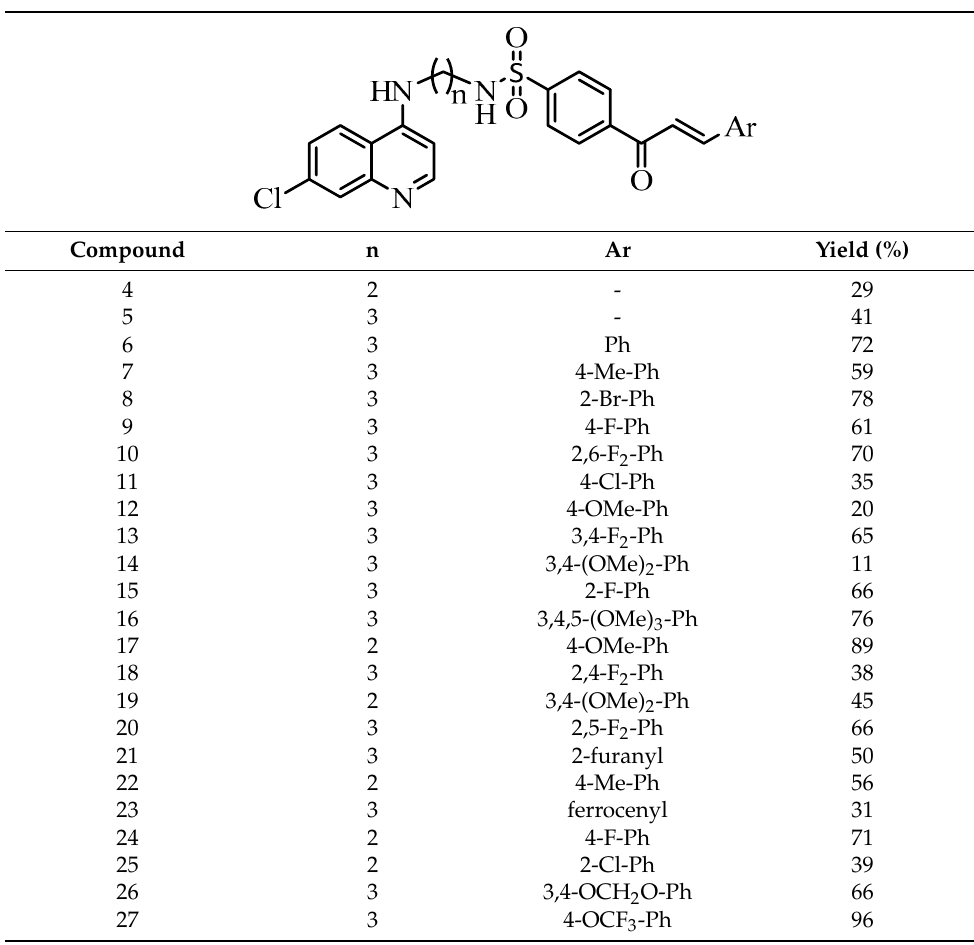
Table 1. Hybrid compounds with isolated yields.